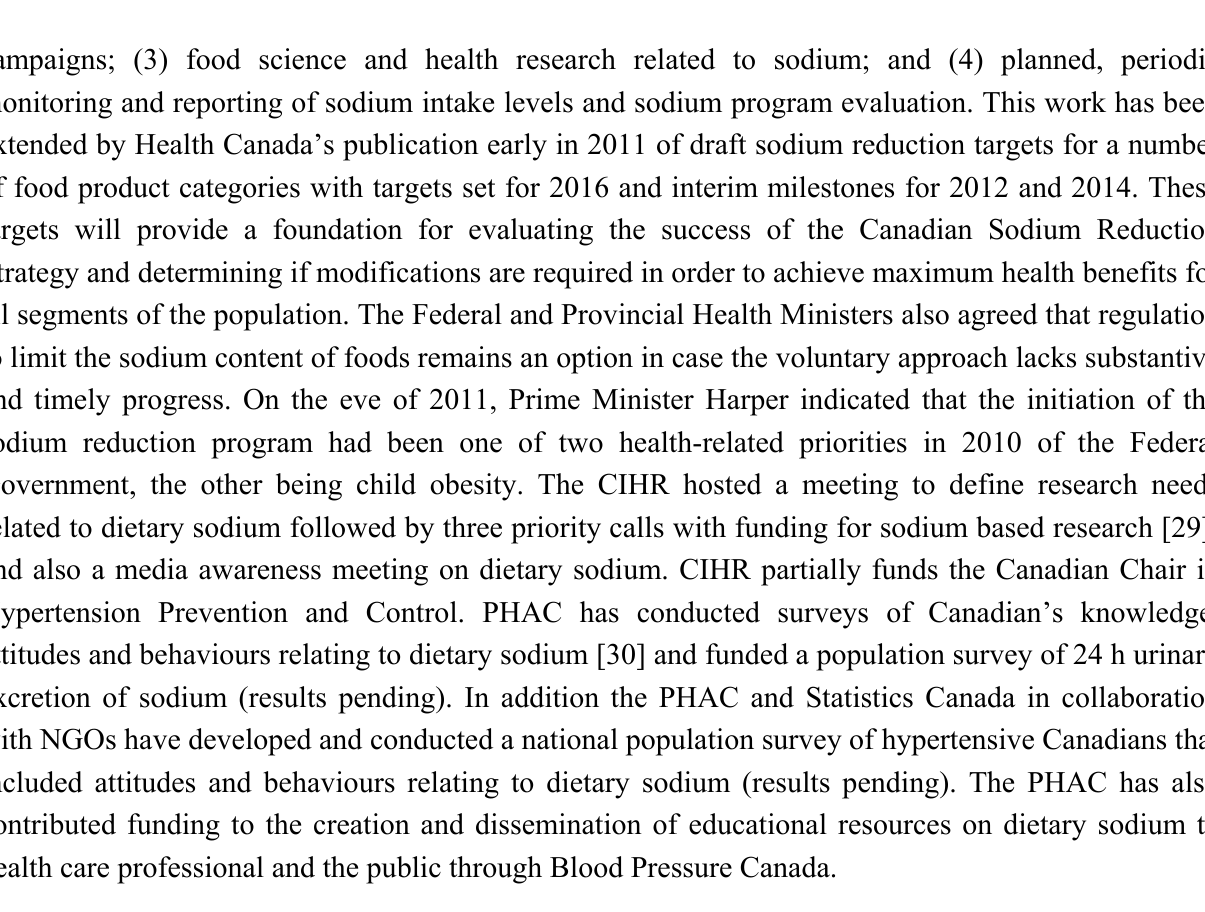
Table 1. Salt intake of Canadians from a 24 h dietary recall study